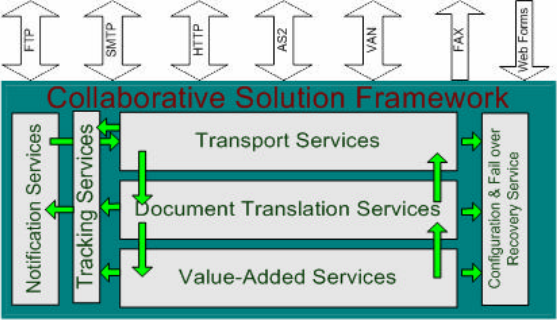
Figure 5: Collaborative Solution Framework Service